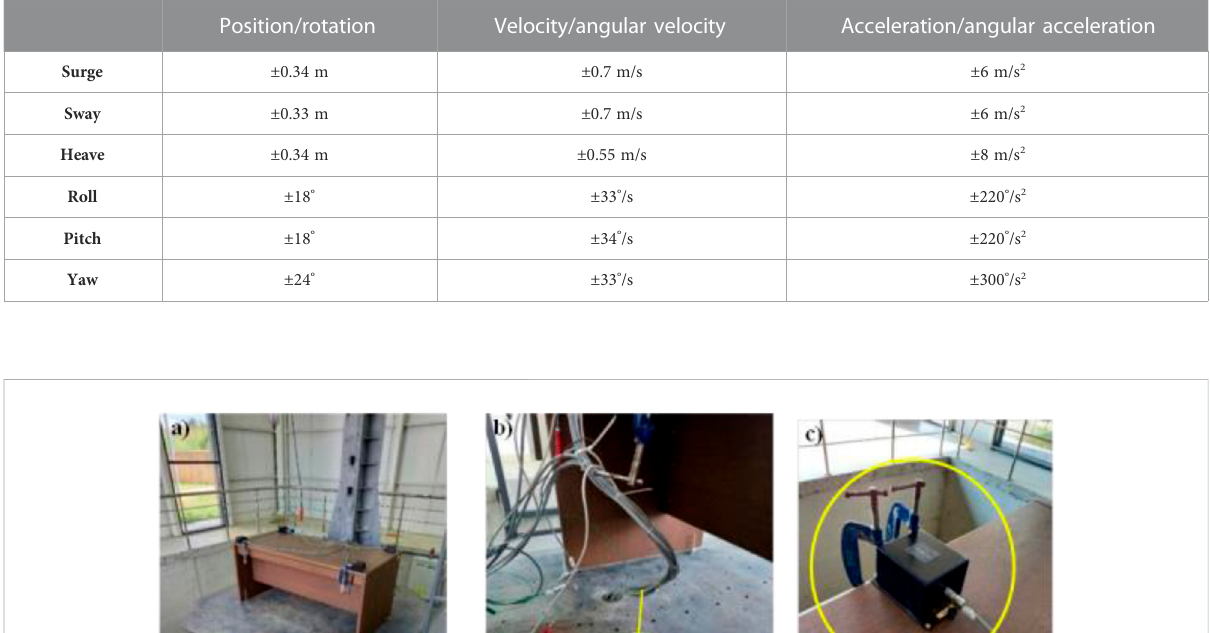
TABLE 3 Mechanical properties of earthquakes (Cavuslu, 2022).